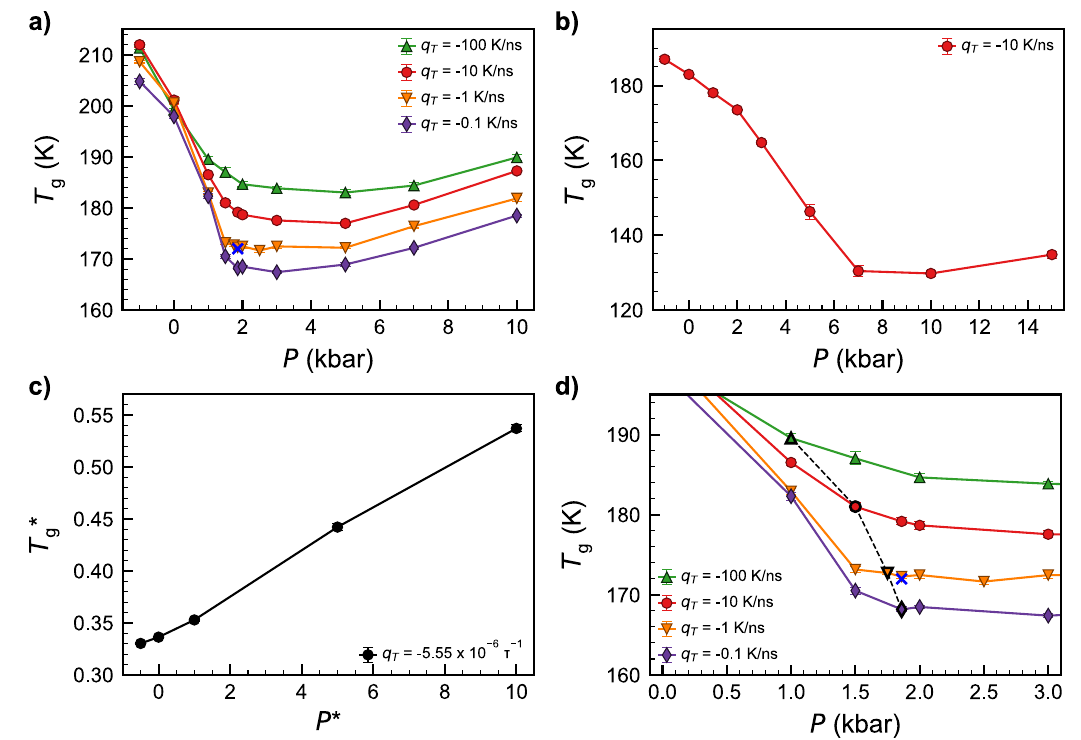
Fig. 3 Glass transition temperature ( T g ) as a function of pressure P . a , d TIP4P/2005, b mW, and c Kob – Andersen mixture. In d , the T g vs. P data is the same as in a but presented on a different axis scale to focus on the near-critical region; the dashed black line denotes the locus of maximum S (0) from Fig. 2, and the blue X denotes the LLCP location from ref. 25 . In all panels, colors and symbols denote different cooling rates ( q T ) as marked and error bars denote 95% con fi dence intervals obtained from the standard error of the mean.